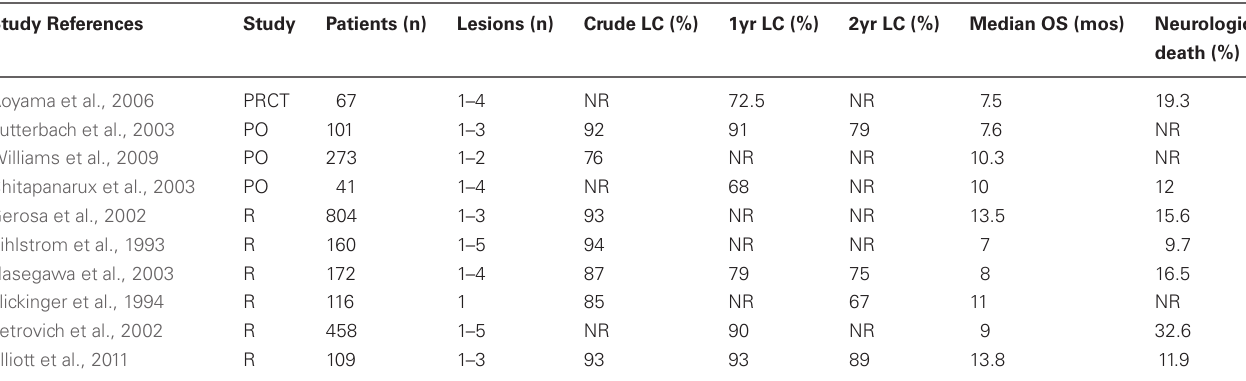
Table 1 | Outcomes following SRS alone for limited brain